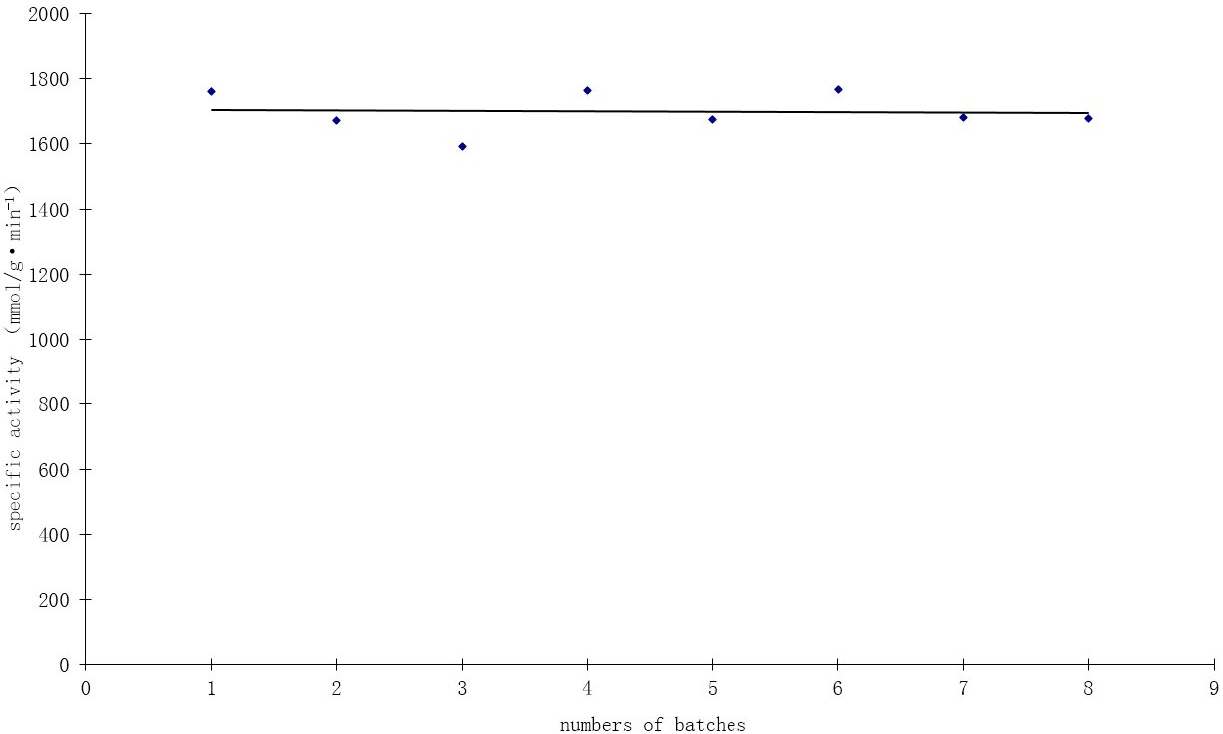
Figure 8. Recycling test of the 1.0 wt % Au/Al 2 O 3 catalyst in the oxidation of